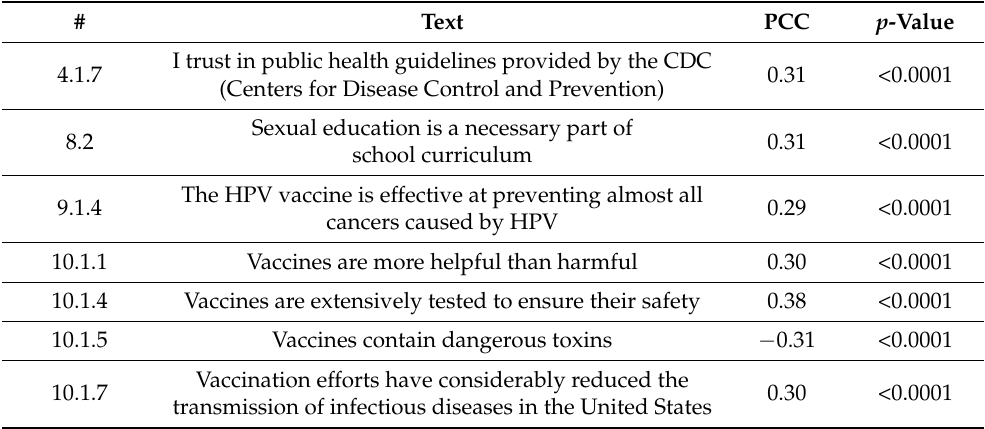
Table 4. Survey items moderately or highly individually correlated with intent to